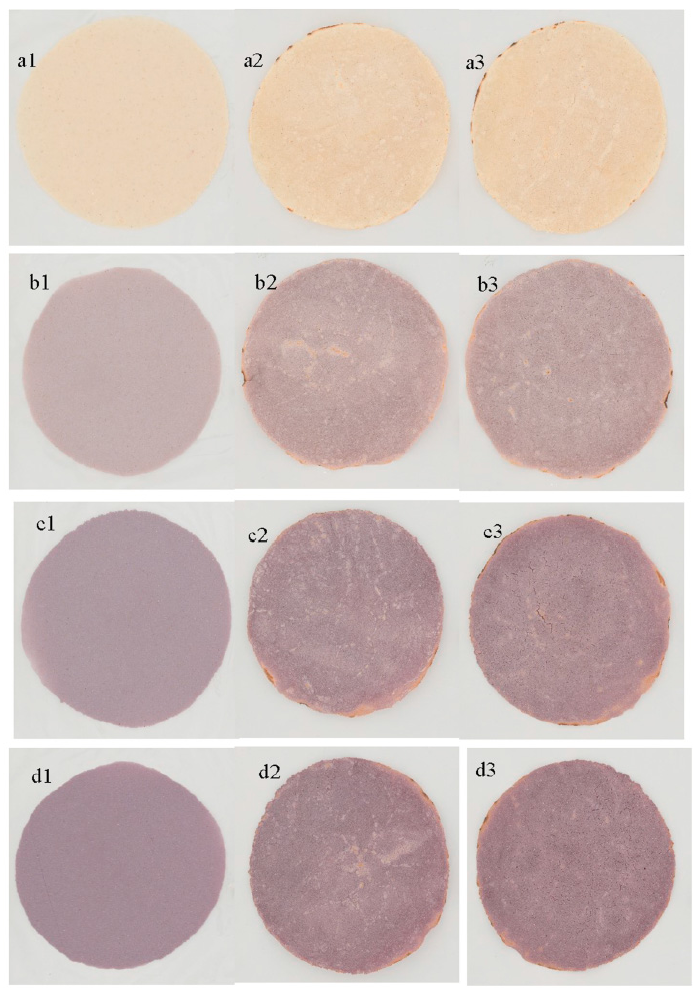
Figure 3. Real images of masa and tortillas containing different concentrations of J . spicigera aqueous extracts. Masa containing 0 ( a1 ), 0.7 ( b1 ), 1.7 ( c1 ) and 2.7 ( d1 ) g/100 g. The subsequent images from left to right correspond to their tortillas of both sides. Reprinted from Ref. [37].